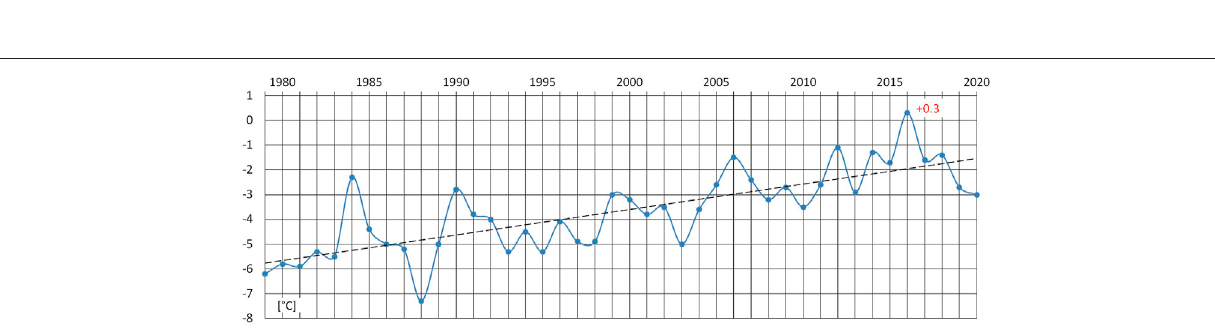
Frontiers in Earth Science |